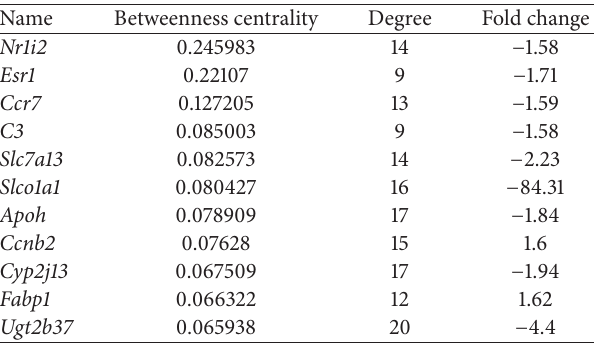
Table 4: Top 10 hub genes from PPI